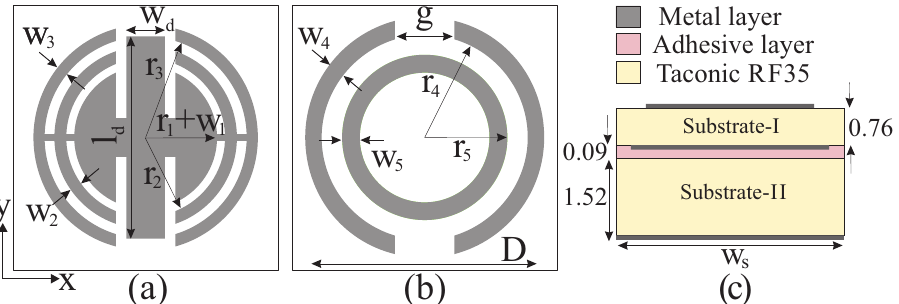
Figure 1. Geometry of the proposed unit cell design: ( a ) Top layer. ( b ) Middle layer. ( c ) Side view. (cid:2) r 1 = variable, r 2 = r 1 + 0.6, r 3 = r 1 + 1.255, r 4 = r 1 + 1.3, r 5 = r 1 + 0.7, gap = r 1 , w 1 = w 2 = w 3 = 0.2*r 1 , w 4 = w 5 = 0.3*r 1 , w d = 0.65*r 1 , l d = 2*r 1 + 2.51, h 1 = 1.52, h 2 = 0.09, h 3 = 0.76, D = 2*(r 4 + w 4 ) = 2.54*r 1 + (cid:3) 2.6 mm